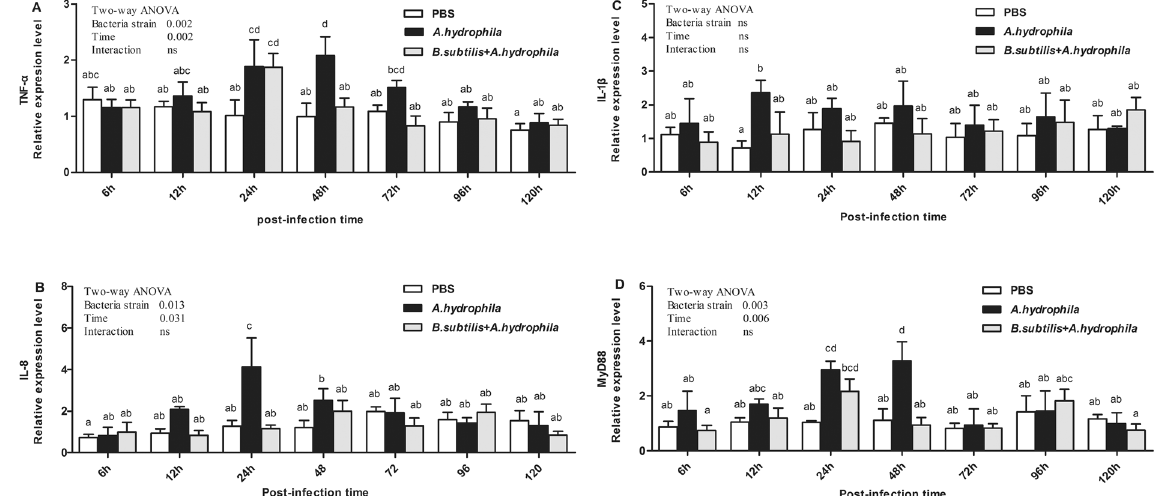
Figure 5. Relative expression of mucosal immune-related genes in the intestine after oral intubation with A. hydrophila . D Results shown are Mean ± SD (n = 6). TNF- α : tumor necrosis factor a; IL: interleukin; MyD88: myeloid differentiation factor